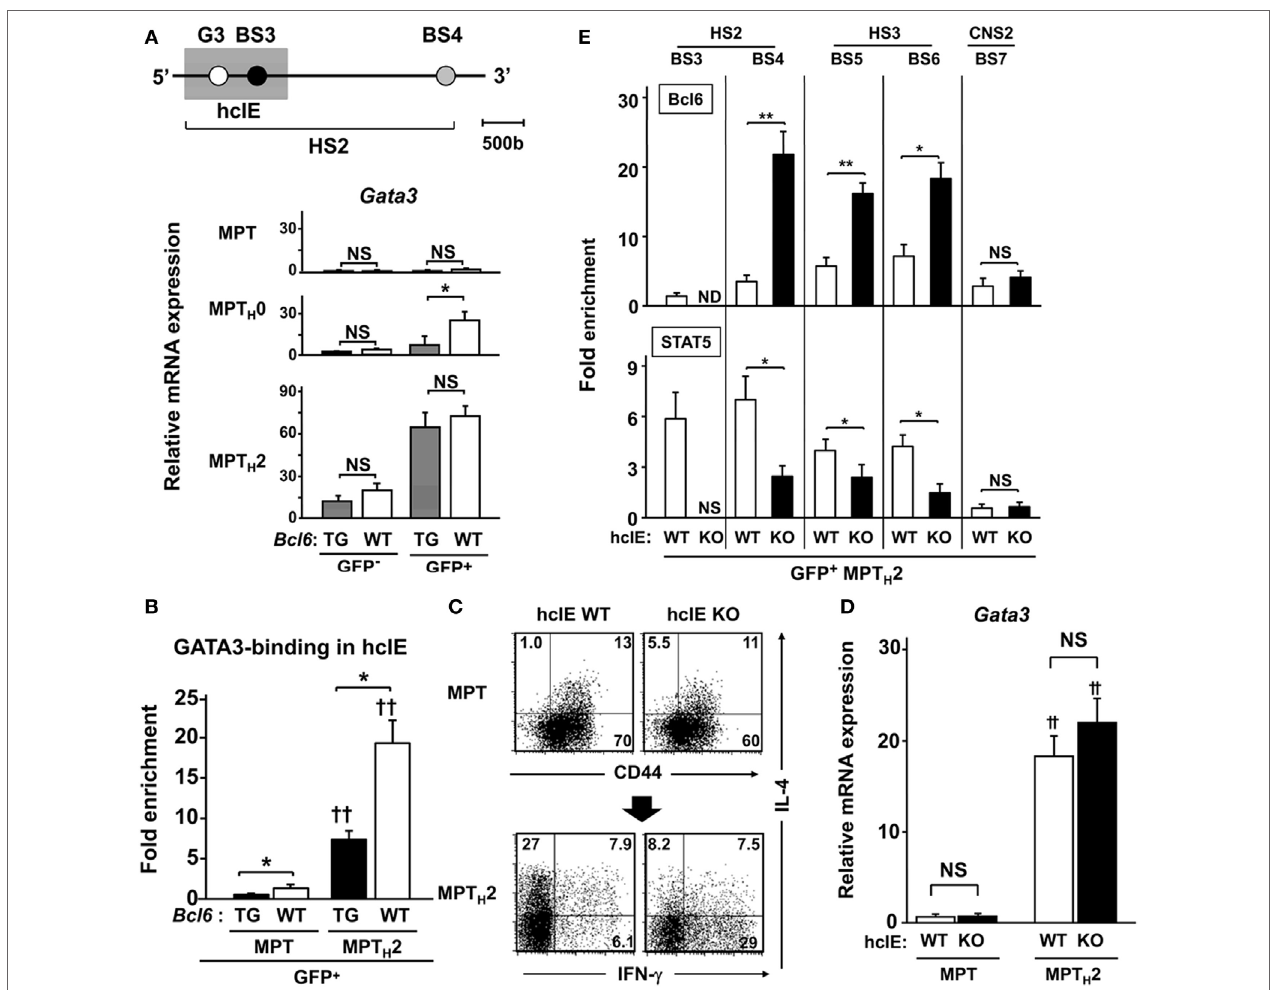
FigUre 5 | Role of Bcl6 in hcIE activity in MPT H 2 cells. (a – D) KJ1-26 + cells among splenic MPT cells were cultured with ovalbumin peptides and antigen-presenting cells in vitro under T H 0 or T H 2 conditions. [ (a) top] Diagram of the HS2 region in Il4 intron 2, indicating regulatory regions. The shaded square indicates the hcIE region including the GATA3-binding site (G3) and BS3 within HS2. (a) Gata3 mRNA levels in GFP + and GFP − MPT, MPT H 0, and MPT H 2 cells derived from Bcl6 -TG and Bcl6 -WT mice on a CNS2-GFP-TG background. (B) GATA3 binding to G3 analyzed by ChIP assays for GFP + MPT and MPT H 2 cells on a CNS2-GFP-TG background. (c,D) Analysis of splenic MPT cells or MPT H 2 cells derived from hcIE-KO or hcIE-WT mice. (a) FACS analysis of intracellular cytokine populations of MPT cells by gating CD4 + CD49b − T cells in the resting phase and MPT H 2 cells restimulated with anti-CD3 monoclonal antibodies. The numbers in the corners represent the percentages among the gated T cells. (D) Gata3 mRNA levels were measured by qRT-PCR for MPT and MPT H 2 cells derived from hcIE-KO and hcIE-WT mice. (e) Bcl6 levels and STAT5 binding to each BS were analyzed by ChIP assay for GFP + MPT H 2 cells from hcIE-KO or hcIE-WT mice on a CNS2-GFP- TG background. All results are representative of three (a,B) or five (c–e) independent experiments with similar outcomes. Data are means ± SEMs ( n = 9–10) . * P < 0.05, comparison between two groups as indicated; † P < 0.05, †† P < 0.01, compared with the MPT cells. Bcl6, B-cell lymphoma 6; BS, binding sequence; ChIP, chromatin immunoprecipitation; CNS, conserved noncoding sequence; FACS, fluorescence-activated cell sorting; hcIE, highly conserved intron enhancer; HS, DNase hypersensitive site; KO, knockout; MPT cell, memory phenotype CD4 + T cell; MPT H 2 cell, MPT cell-derived T H 2 cell; ND, not detected; NS, not significant; TG, transgenic; WT,